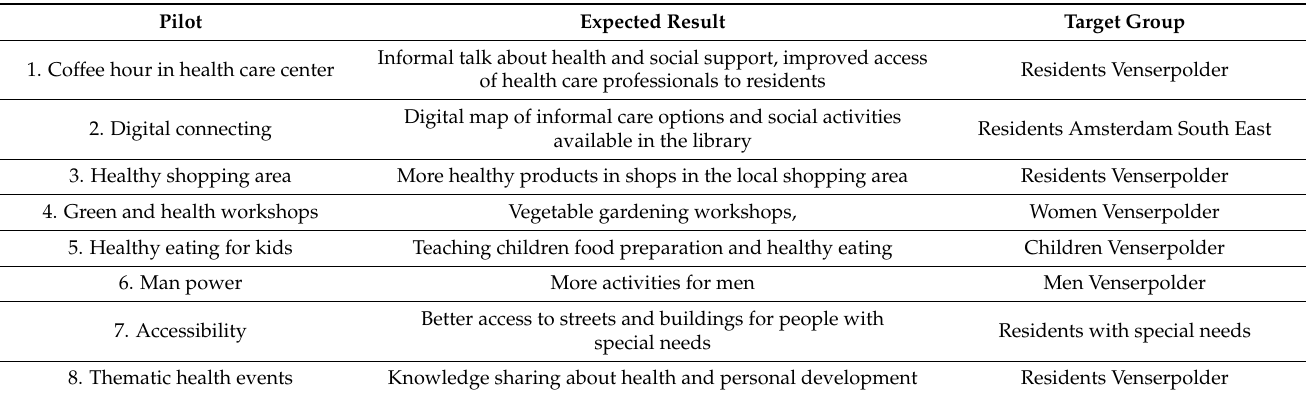
Table 1. Overview of the health promotion pilots in the case study.